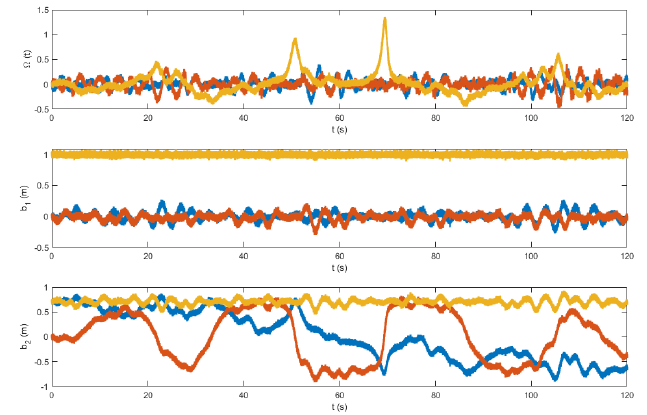
Figure 13. The vector measurements of the flight in terrain